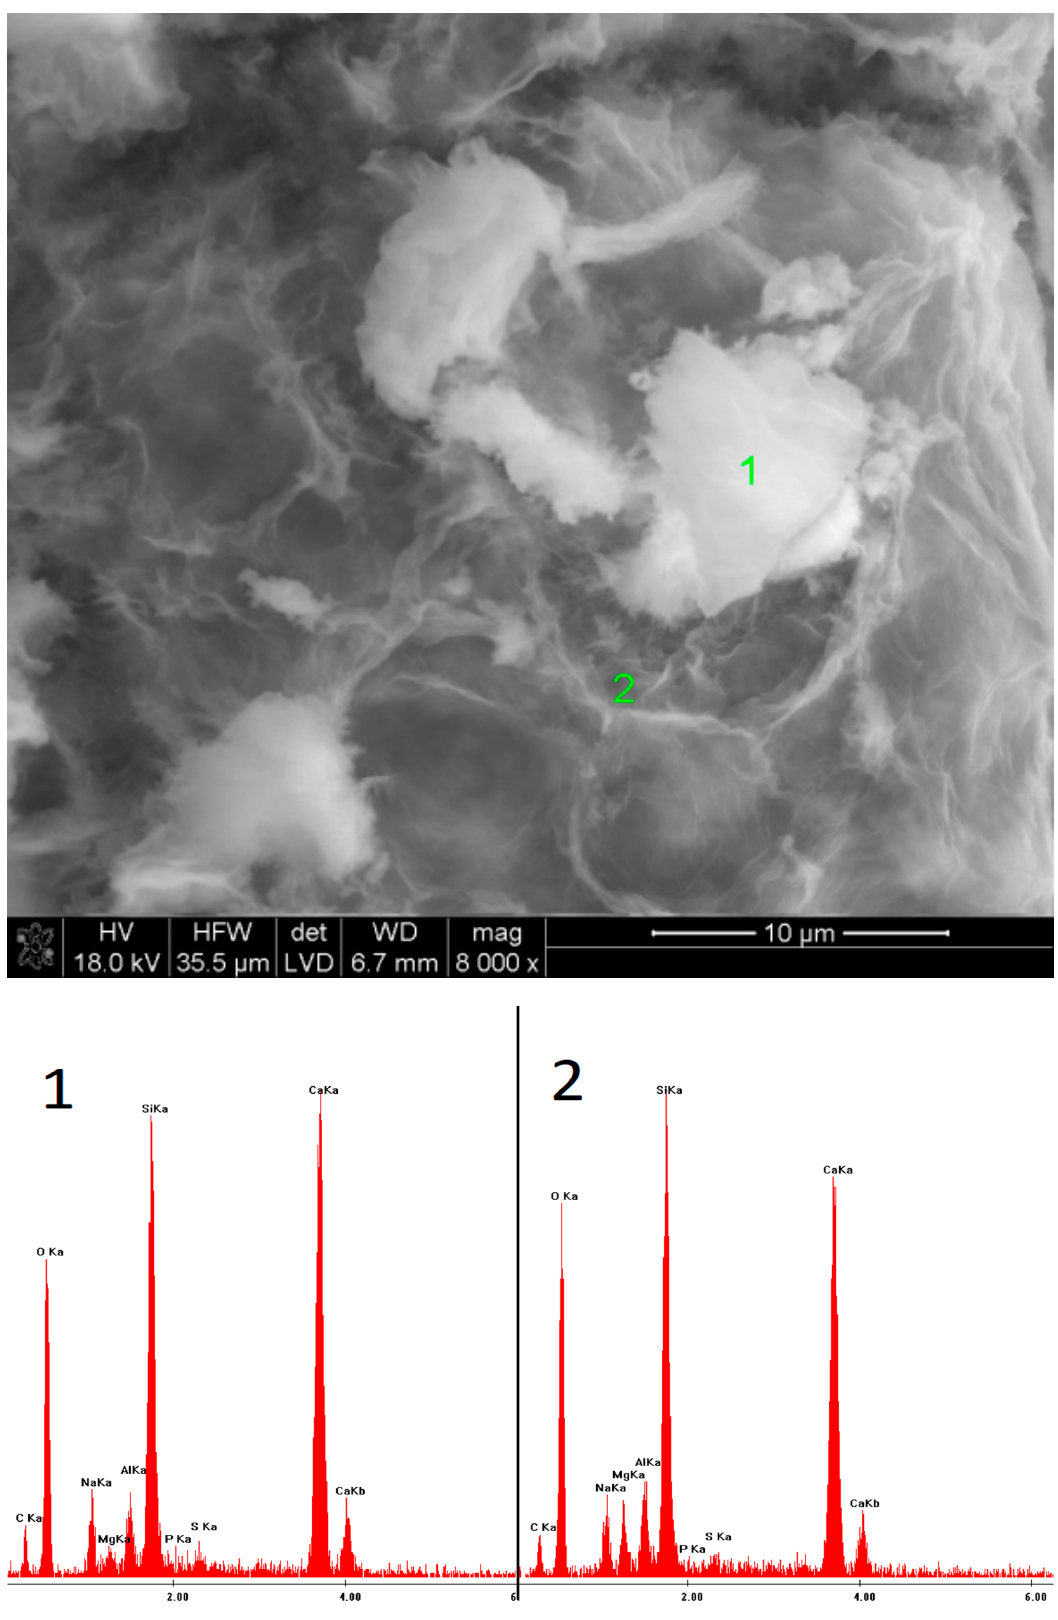
Figure 14. Microstructure of slag paste activated with sodium hypophosphite after 360 days of curing—SEM + EDS; 1 , 2 —a layer of hydration products covering the slag grains.